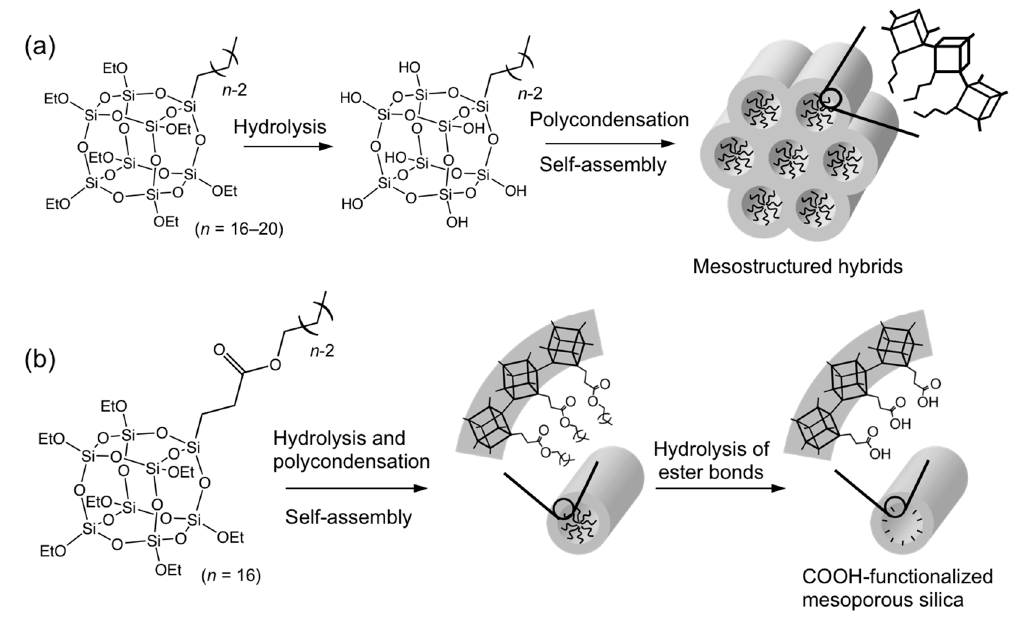
Figure 4. Synthesis of mesostructured materials by surfactant-free self-assembly of ( a ) cage siloxanes with a long alkyl group and ( b ) cage siloxanes with a long-chain alkyl ester group and subsequent hydrolysis of the ester bonds.